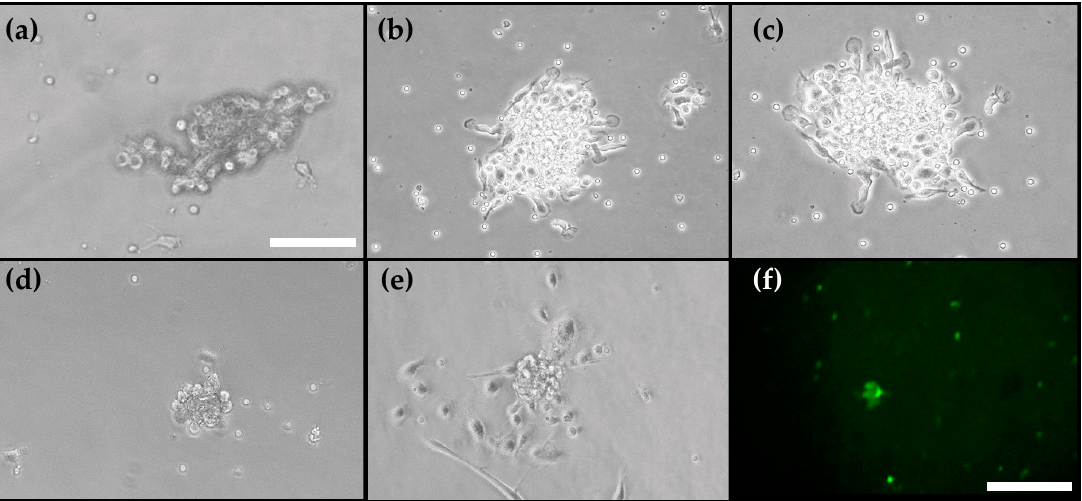
Figure 4. Morphology of CFUs. Light-inverted microscope view of EPCs under 100× magnification after 48 h-treatment of negative control (untreated) ( a ), 1 μ g/mL PSP extract ( b ), 25 μ g/mL PSP extract ( c ), 10 μ g/mL L -ascorbic acid ( d ), and 250 μ g/mL L -ascorbic acid ( e ). ( f ) FITC-labelled CD34 immunofluorescence expression of EPCs. White bar represent 100 μ m.